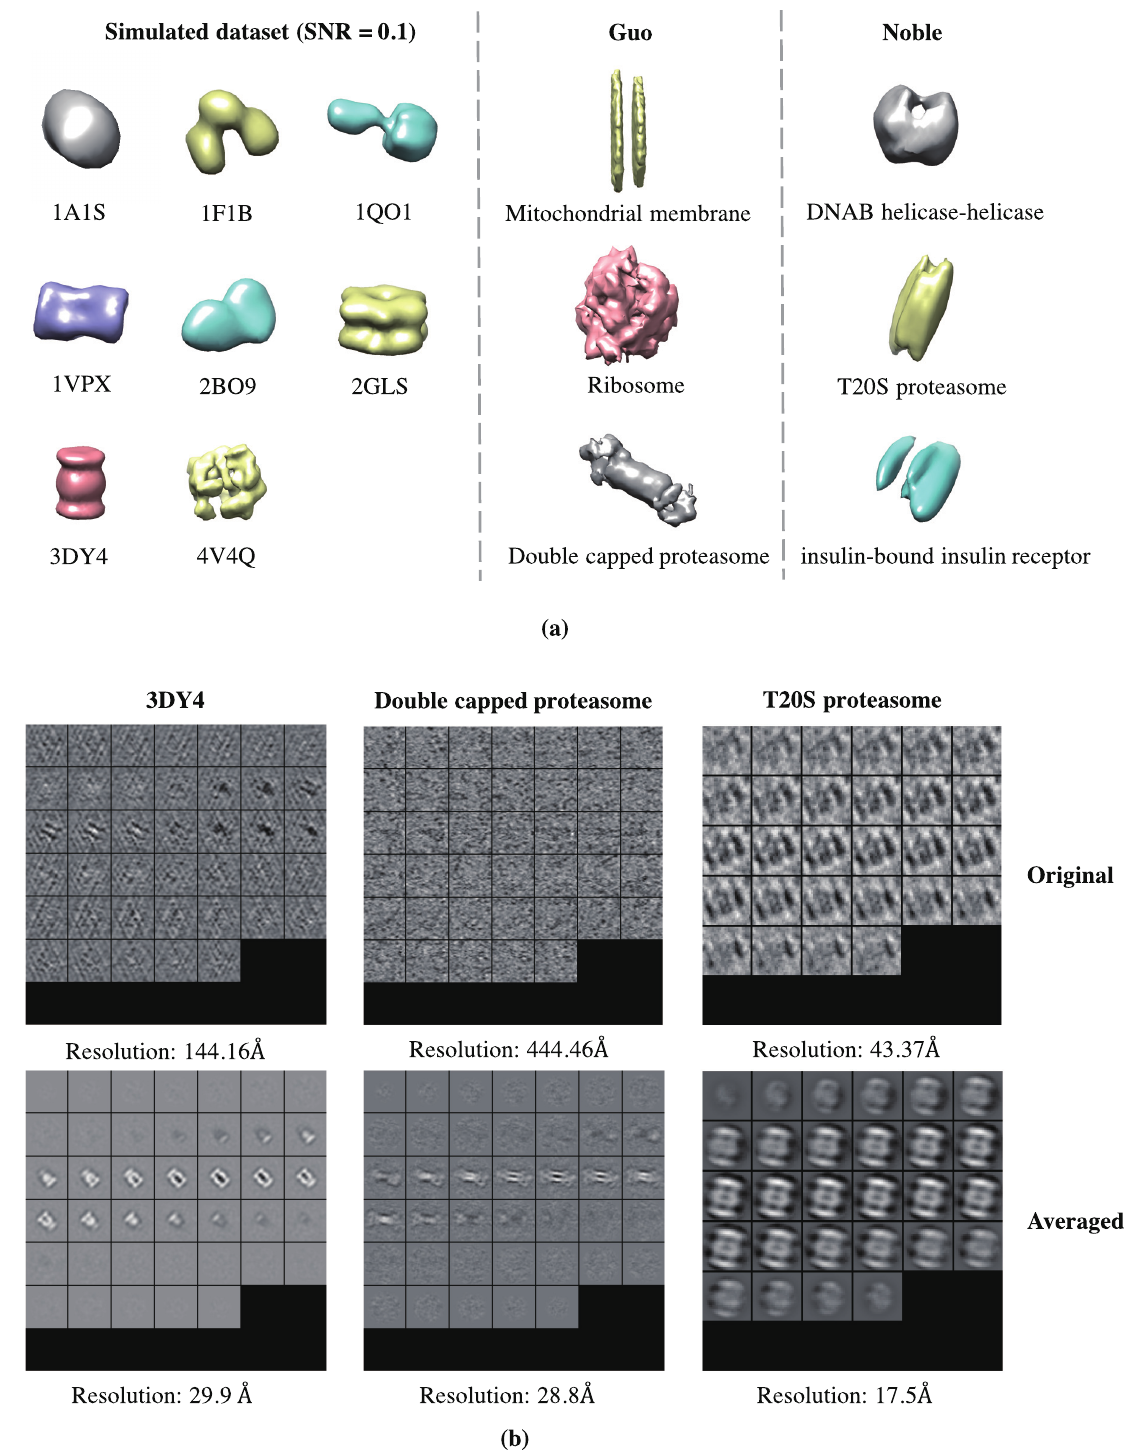
Fig 4. The results of subtomogram averaging. (a) Averaged subtomograms after classification. (b) Examples of original subtomograms (before classification) compared to averaged subtomograms (shown in 2D slices).